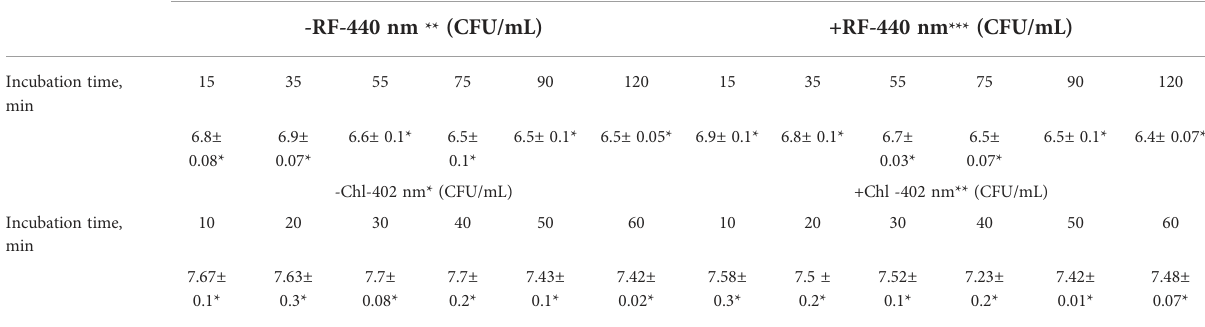
TABLE 2 CFU counts of dark controls (reported in log 10 scale) of the planktonic cells.